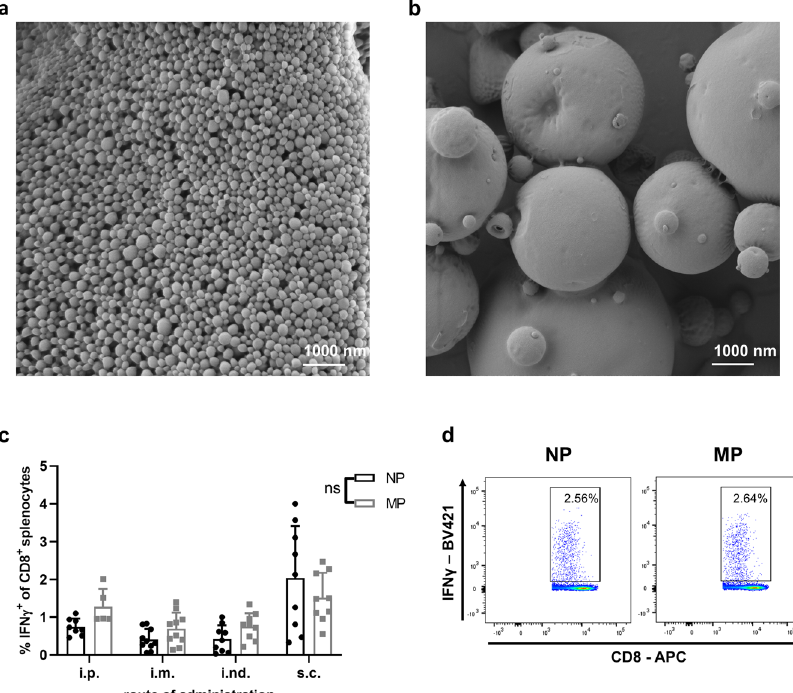
Fig. 1 Nano- or micron-sized PLGA particles containing ovalbumin (OVA) and Riboxxim are potent vaccine delivery systems for vaccination. a , b Size distribution and morphology of nanoparticles ( a ) and microparticles ( b ) containing encapsulated OVA and Riboxxim were analyzed by scanning electron microscopy (SEM). Scale bars, 1000 nm. SEM images were acquired from three different particle batches with similar results. c C57BL/6J mice were immunized with nanoparticles (NP, black dots) or microparticles (MP, gray squares) charged with OVA protein (250 µ g/mouse) and Riboxxim (2.5 µ g/ mouse) via the intraperitoneal (i.p., n = 8 for NP, n = 5 for MP), intramuscular (i.m., n = 10 for NP, n = 10 for MP), intranodal (i.nd., n = 9 for NP, n = 9 for MP), or subcutaneous (s.c., n = 9 for NP, n = 9 for MP) route demonstrating the latter as most ef fi cient. Six days post-immunization, an intracellular cytokine staining for IFN γ + of CD8 + splenocytes was performed and analyzed via fl ow cytometry. Statistics: two-way ANOVA followed by Š ídák ’ s multiple comparisons test with ns, not signi fi cant. Data are presented as means ± SD and represent pooled data from three independent experiments. d A representative dot plot showing the frequency of IFN γ + CD8 + splenocytes for indicated treatment groups.